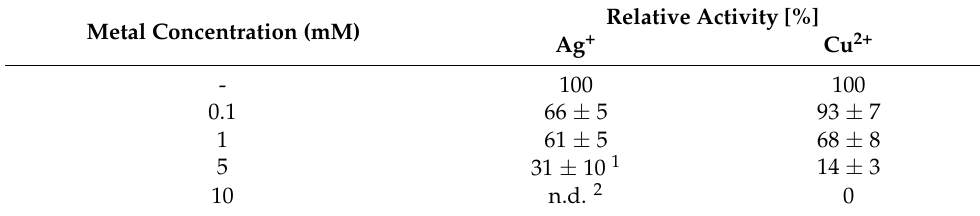
Table 2. Effect of copper and silver ions on the activity of enzyme NitEg. Metal Concentration